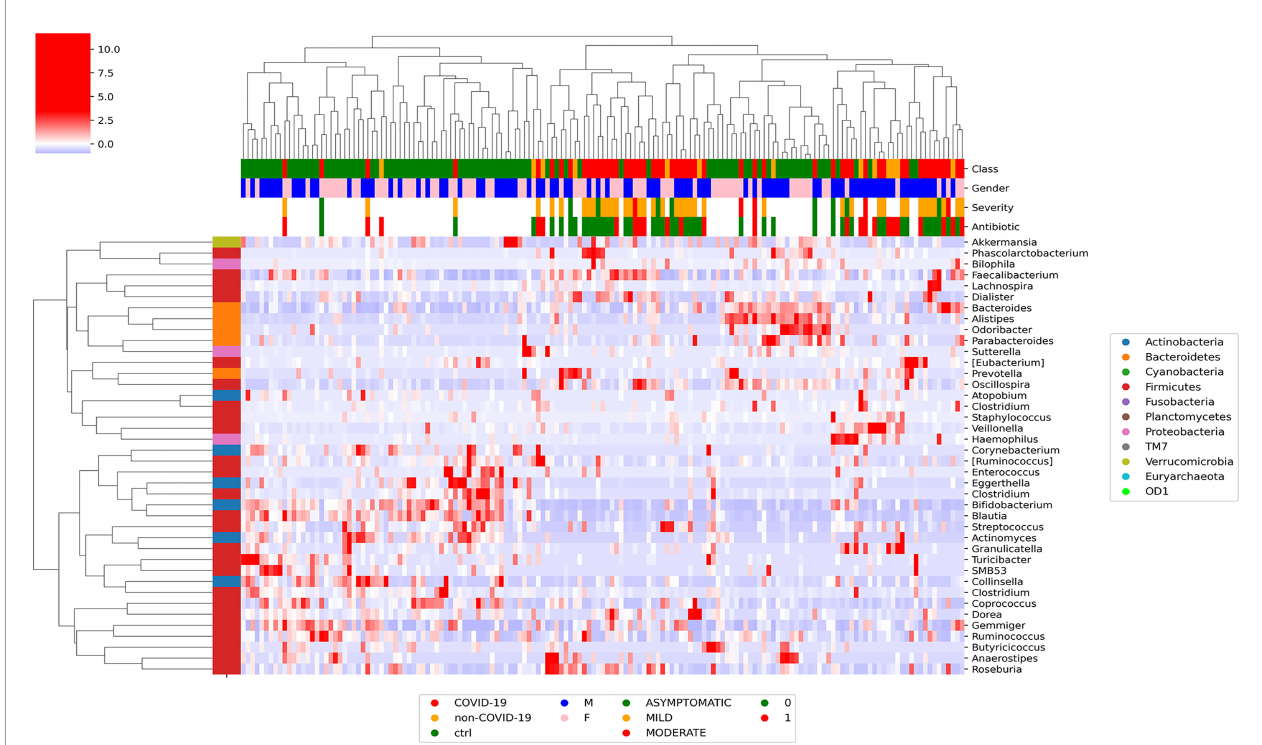
FIGURE 1 | Graphical representation of hierarchical analysis of global ASV distribution at L6 (genus) for COVID-19 and CTRL subjects fi ltered by a t-test between classes with p -value < 0.05 at T 0 . In the heatmap, the hierarchical complete linkage dendrogram is based on the ASVs Pearson ’ s correlation coef fi cient. The color scale characterizes the Z-score for each variable: red, high level; blue, low level. The column color labels represent respectively: patient ’ s class (red, COVID-19; orange, Non – COVID-19; green, CTRLs), gender (blue, male; pink, female), severity (green, asymptomatic; orange, mild; red, moderate), and antibiotic [green, absent (0); red, present